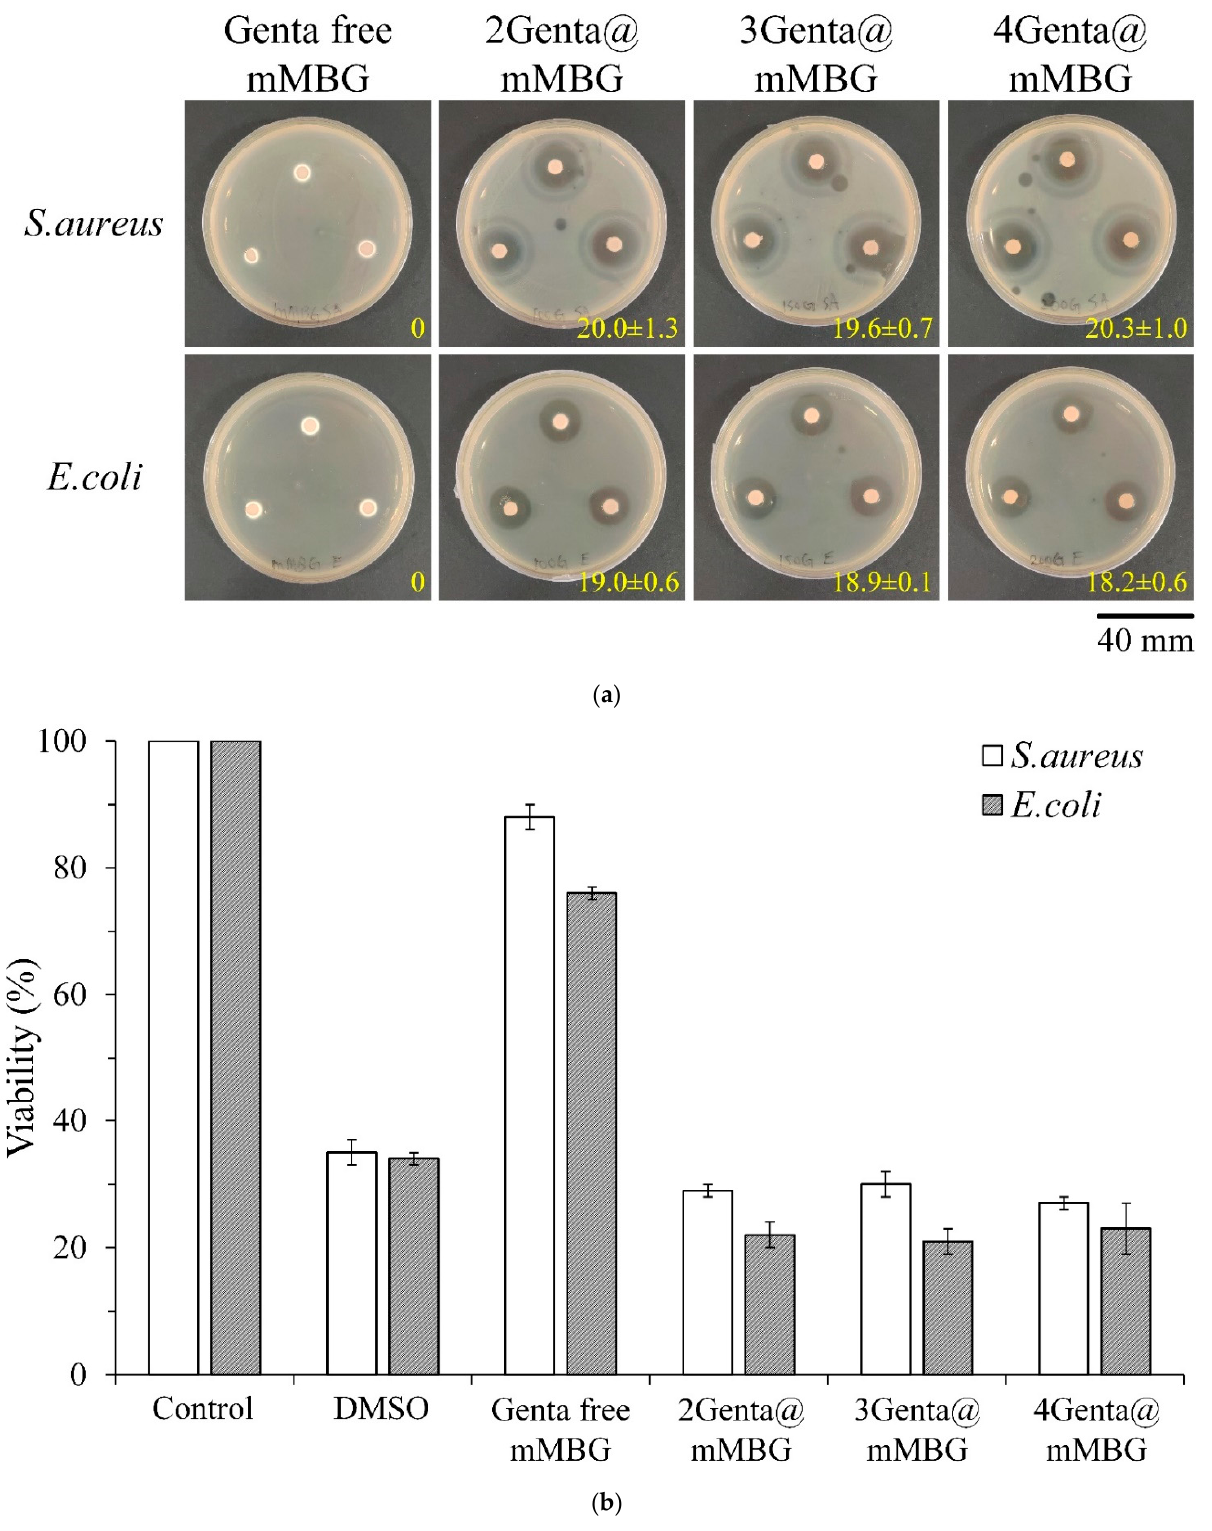
Figure 4. ( a ) Zone of inhibition and ( b ) relative quantitative antibacterial activity against Gram- positive S. aureus and Gram-negative E. coli in the presence of control Genta-free mMBG and mMBG impregnated with Genta at different concentrations for 1 day ( n = 3).